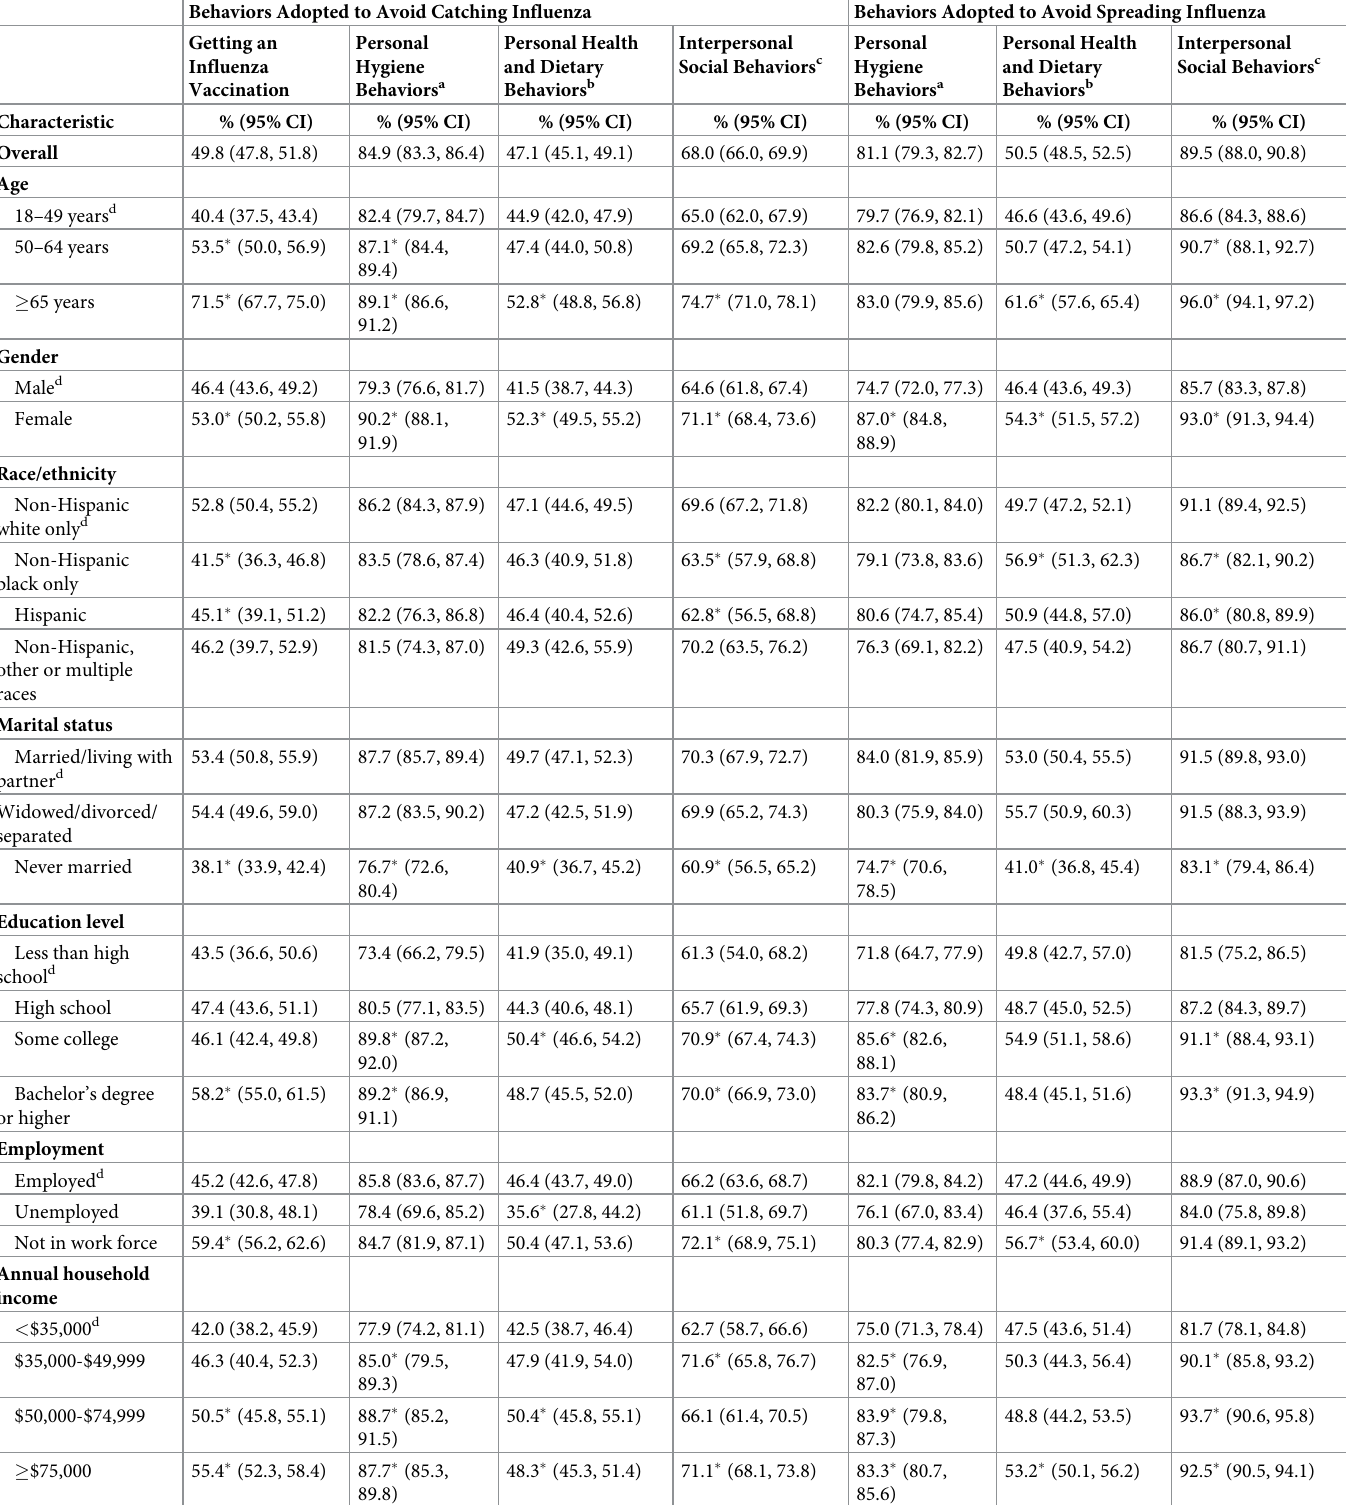
Table 2. Unadjusted preventive behaviors used by adults to avoid catching or spreading influenza by sociodemographic characteristics. Behaviors Adopted to Avoid Catching Influenza Behaviors Adopted to Avoid Spreading Influenza Getting an